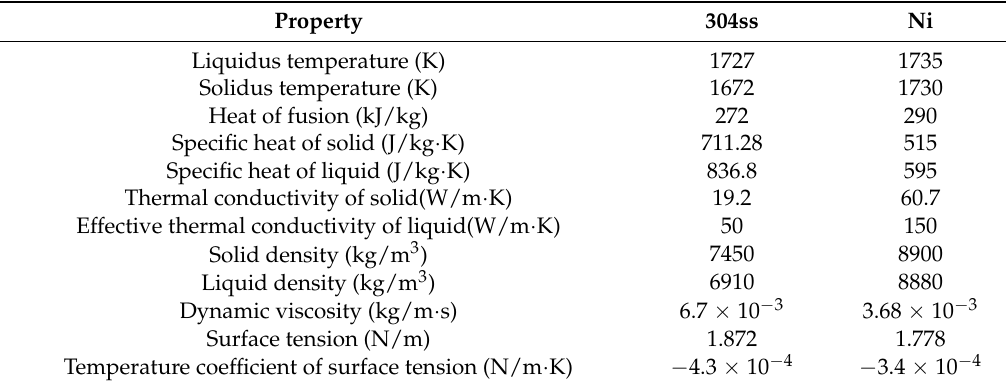
Table 4. Thermal physical properties used for the simulation, data from [21,22].